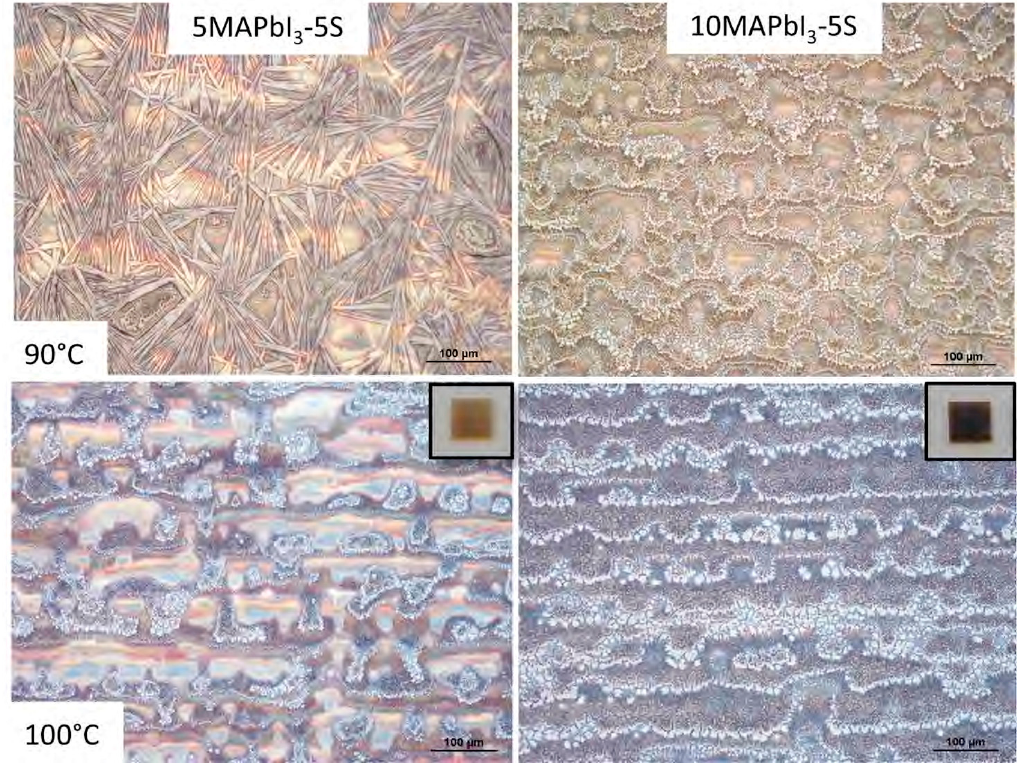
Figure 5. Optical images of 5MAPbI 3 -5S and 10MAPbI 3 -5S samples printed at 90° and 100 °C, and photo of the 5 × 5 mm 2 printed pattern in the inset.